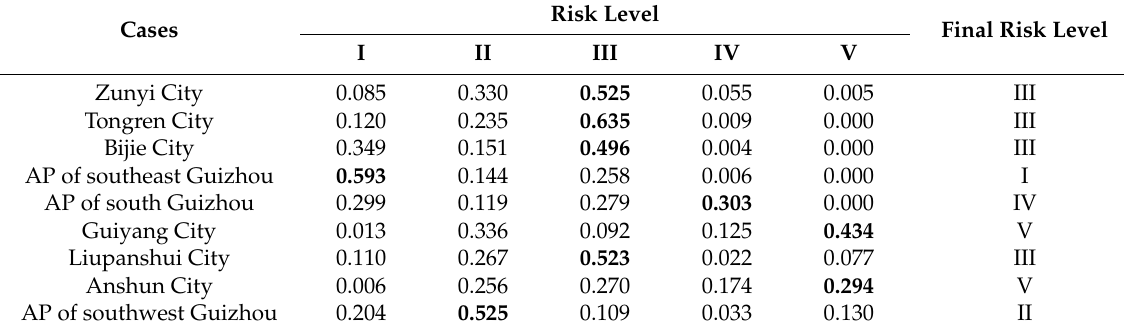
Table 22. Comprehensive evaluation outcomes of mountain torrent disasters in Guizhou